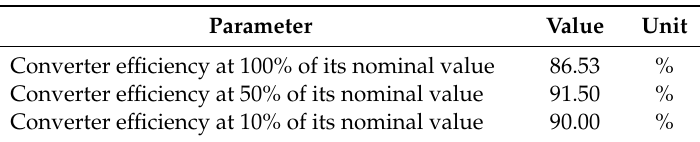
Table 5. Converter specifications.